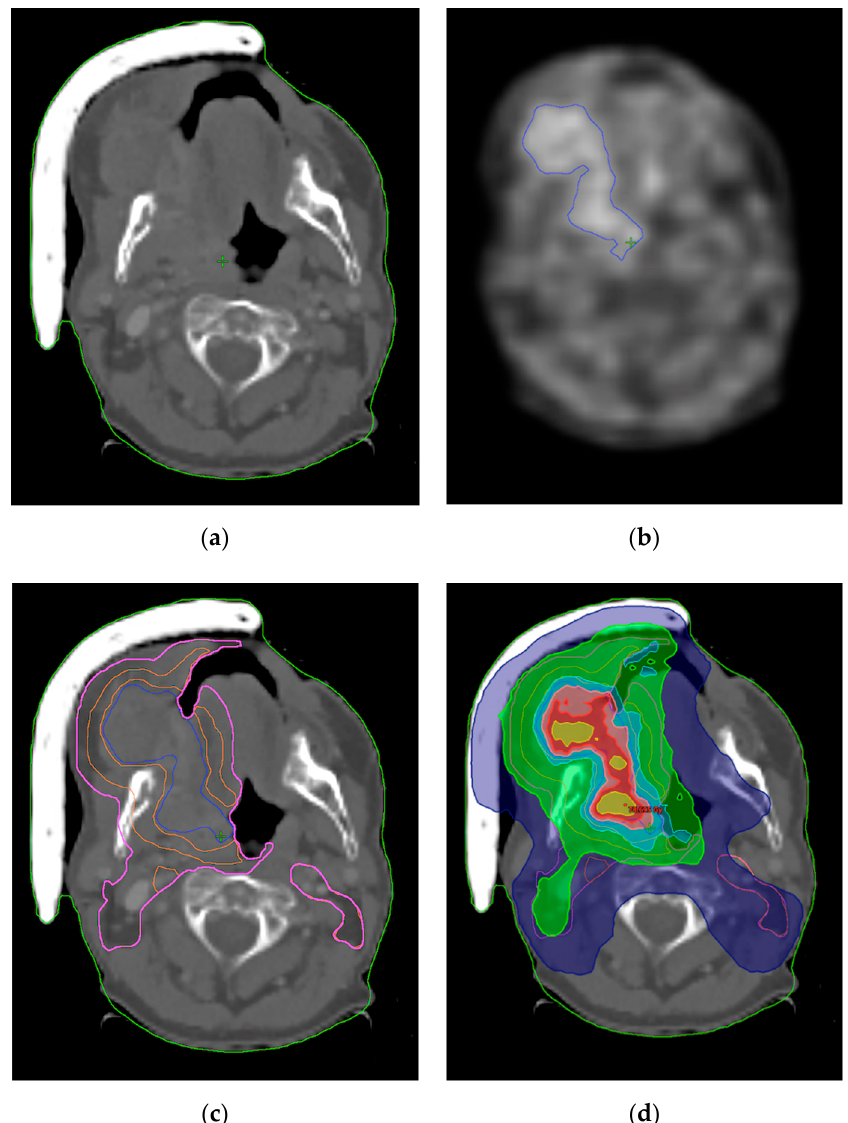
Figure 1. Dose escalation in patient with cancer of oral cavity using FMISO. ( a ) Planning CT; ( b ) PET/CT using FMISO with hypoxic region (blue contour); ( c ) Planning CT with contours; (hypoxic region-blue, 70 Gy isodose-orange, 50 Gy isodose-pink; ( d ) Dose distribution with escalation in the hypoxic region. Dark blue-60% of the prescribed dose, 42 Gy, Green-95% of the prescribed dose, 66.5 Gy, Cyan-103% of the prescribed dose, 72.1 Gy Pink-105% of the prescribed dose, 73.5 Gy, Red-108.5% of the prescribed dose, 75.9 Gy Yellow-110% of the prescribed dose, 77 Gy